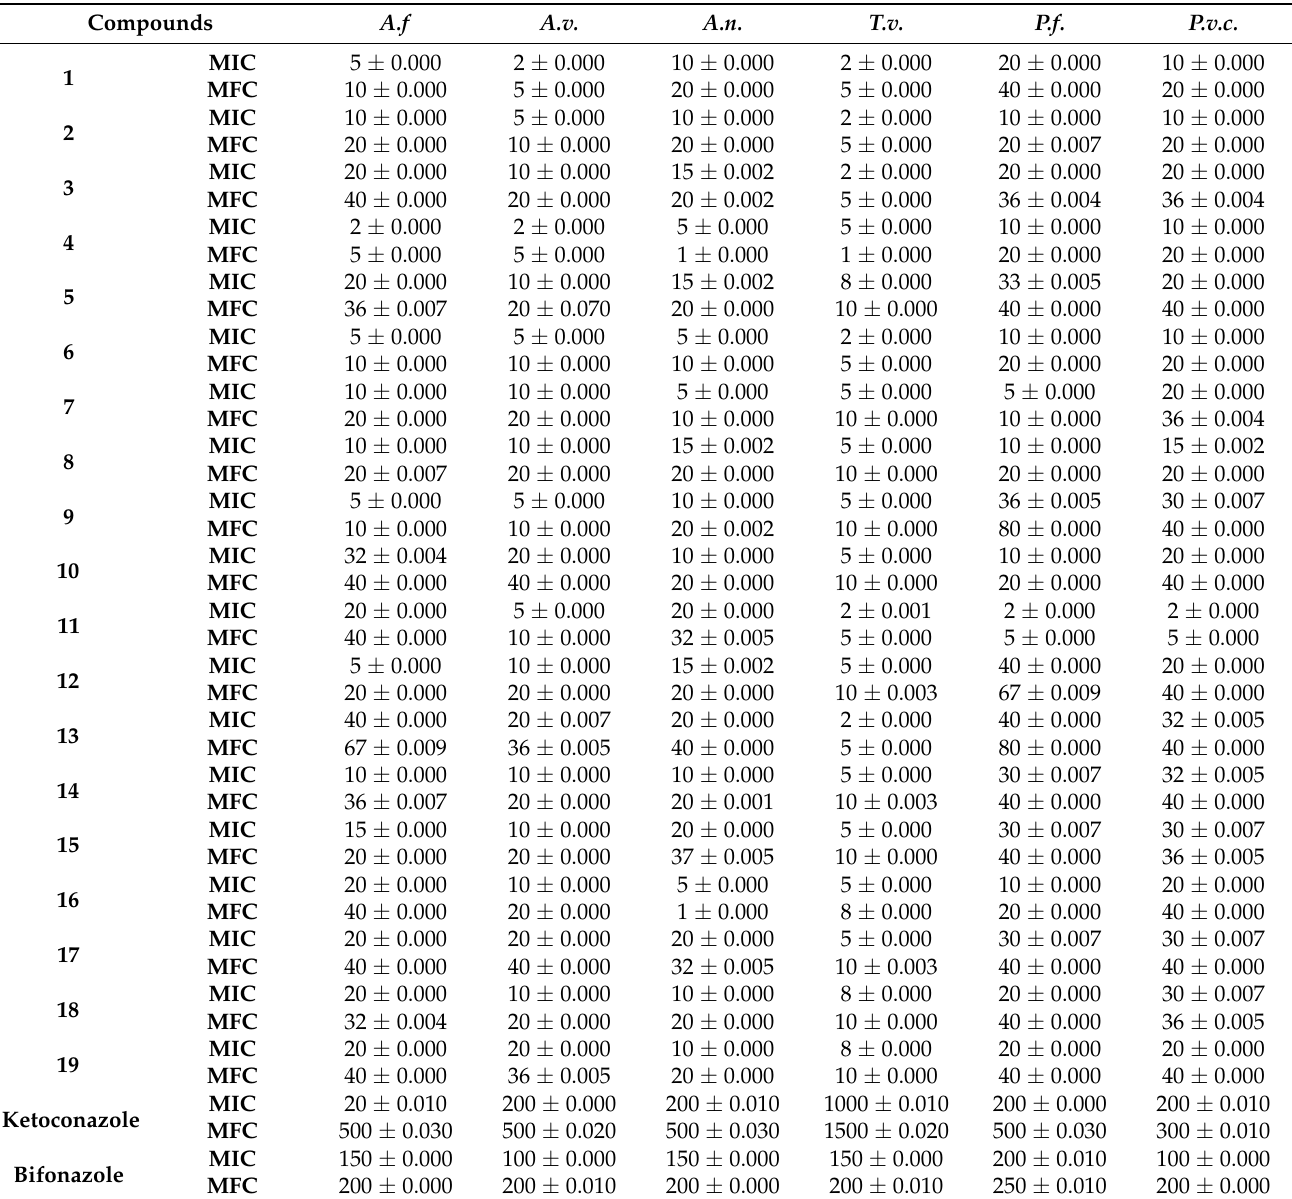
Table 5. Antifungal activity of compounds 1 – 19 . (MIC and MFC in µ g/mL).